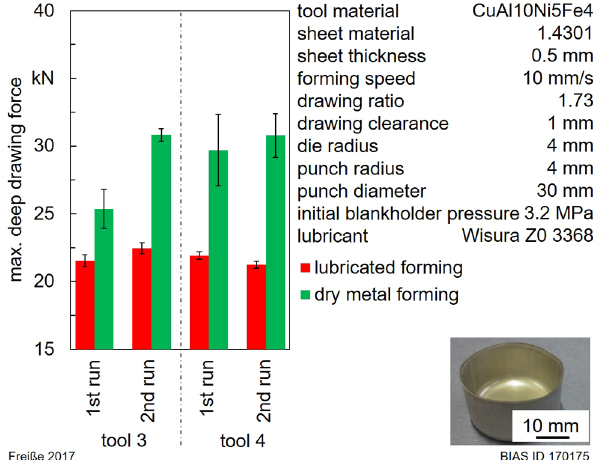
Fig. 18. Maximum deep drawing forces using milled bronze tool by repeated forming tests.